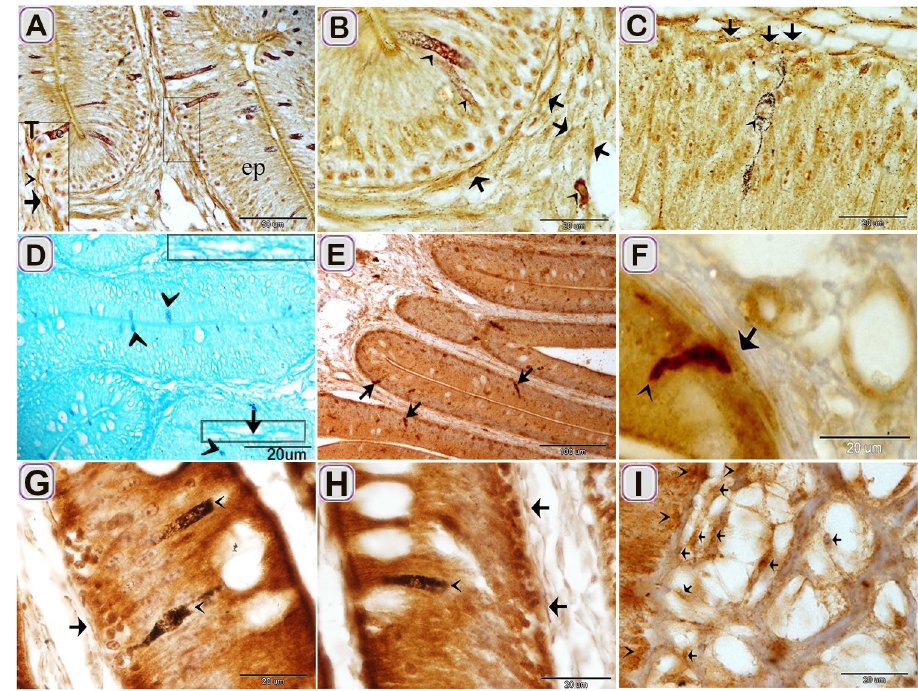
Figure 6. Relation between TCs and epithelial and interstitial endocrine cells using Grimelius’s silver nitrate stain, performic acid with methylene blue, Marsland stain, and immunohistochemical staining using chromogranin A. Paraffin sections stained by Grimelius’s silver nitrate stain, ( A – C ), performic acid with alcian blue ( D ), Marsland stain ( G , H ), chromogranin A ( E , F , I ). ( A – C ) subepithelial TCs (T, arrows) were closely related to endocrine cells (arrowheads). ( D ) subepithelial TCs (arrows) were closely related to endocrine cells (arrowheads). ( E ) chromogranin positive cells within the lining epithelium (arrows). ( F , G , H , I ) subepithelial and interstitial TCs (arrows) were closely related to endocrine cells (arrowheads).